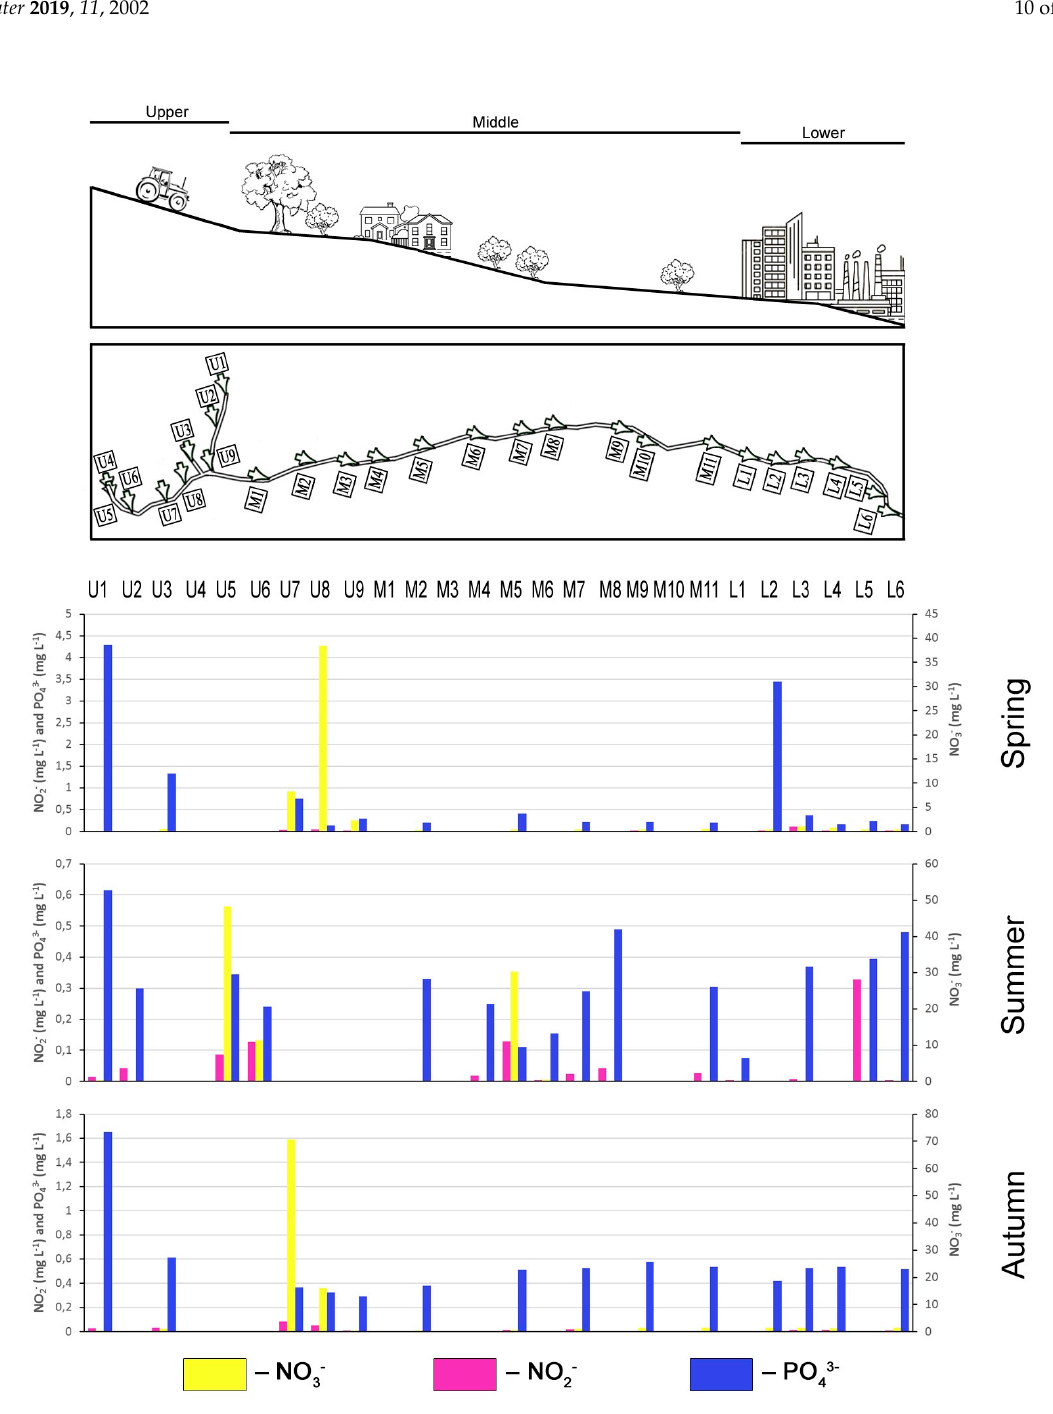
Figure 5. The concentrations of various ions determined by principal component analysis at different sampling points along the Tócó. The nitrate ion is yellow, the nitrite ion is purple, and the orthophosphate ion is